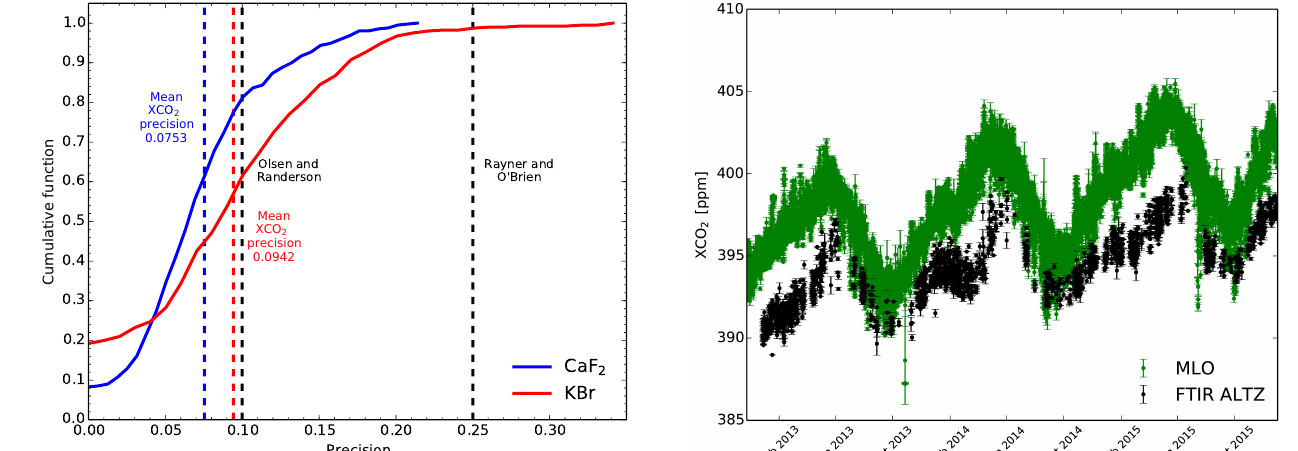
(FTIR ALTZ, black 2